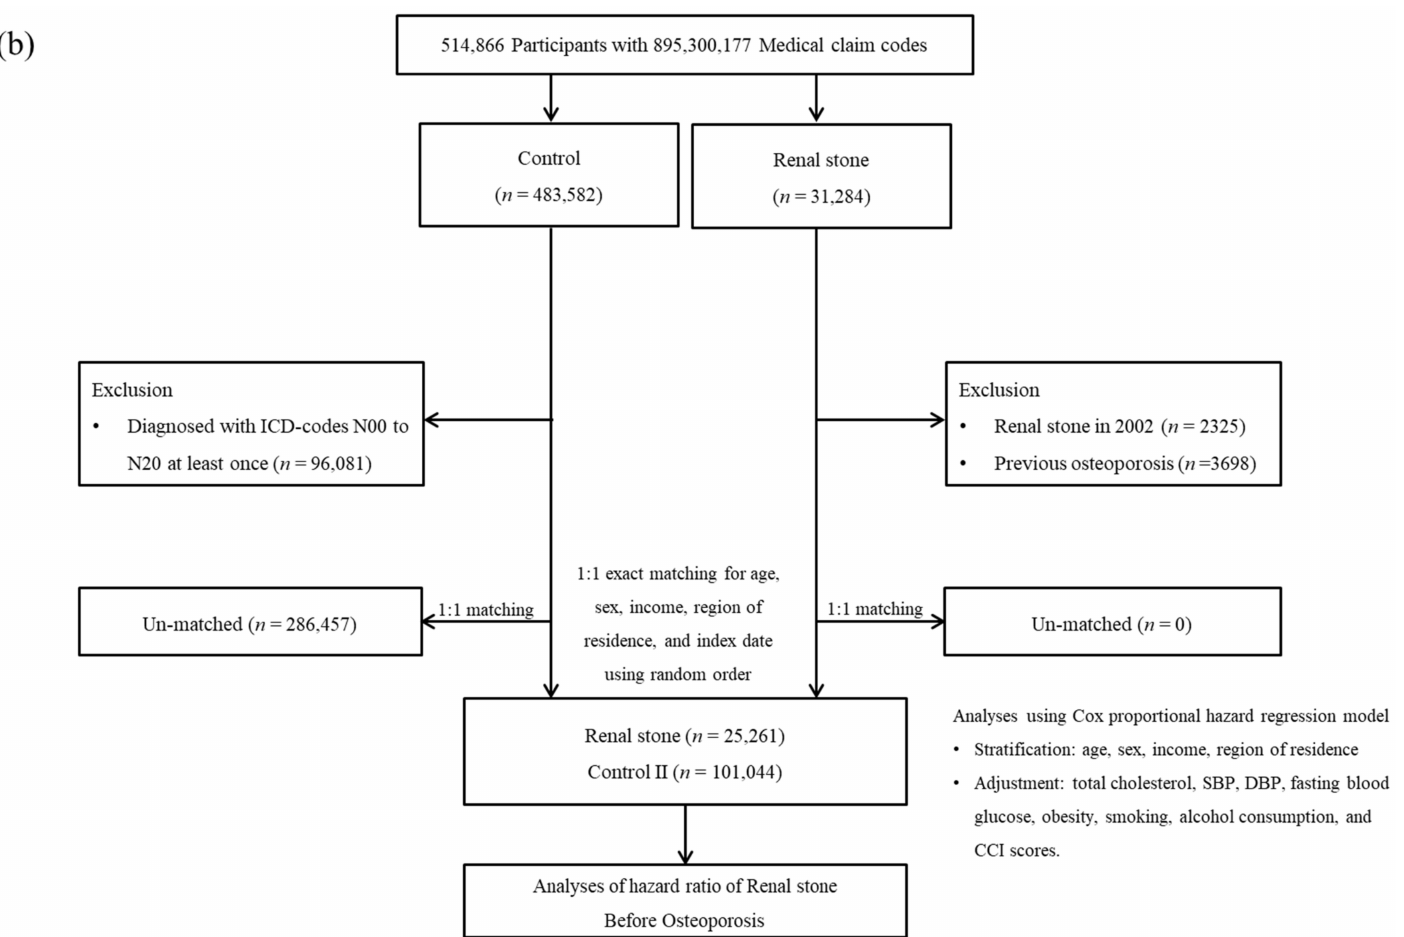
Figure 1. ( a ) A schematic illustration of the participant selection process that was used in the present study. Of a total of 514,866 participants, 67,811 osteoporosis participants were matched with 67,811 control participants for age, sex, income, and region of residence. ( b ) A schematic illustration of the participant selection process that was used in the present study. Of a total of 514,866 participants, 25,261 renal stone participants were matched with 101,044 control participants for age, sex, income, and region of